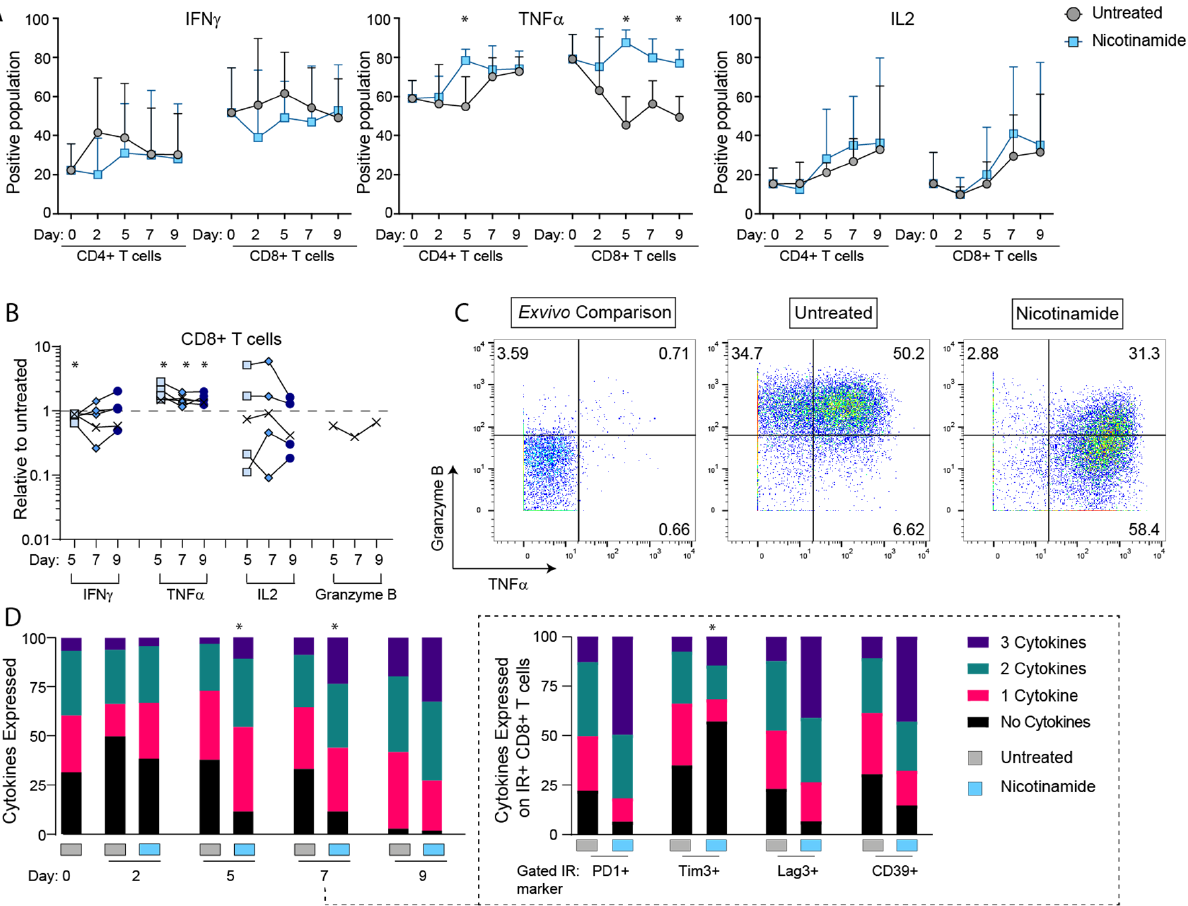
Figure 2. Intracellular cytokine production in the continues presence of NAM. NAM induces higher production of TNF and IL2 in both CD4+ and CD8 T cells and higher production of IFN in CD8+ T cells. ( A ) Time course shown for average across four flow cytometry experiments, with error bars indicating standard deviation, and statistical significance between treated and untreated indicated by * as determined using the Holm-Sidak method ( α = 0.05). Additional statistics performed on ( B ) combined data when compared to untreated only for each time point, on days five to nine across n = 5 in vitro stimulation experiments, mann-whitney test ( p < 0.05 indicated by *), and ( C ) repre- sentative plots showing difference in granzyme B and TNF α expression patterns. ( D ) Cumulative cytokine expression of total CD8+ T cells, and ( D ) inset IR expressing CD8+ T cells as scored for representative experiment shown in 2A, showing significance by chi-squared analysis (* p < 0.05). Data points marked in ( B ) as ‘X’ were obtained from mass cytometry analysis, with remainder from flow